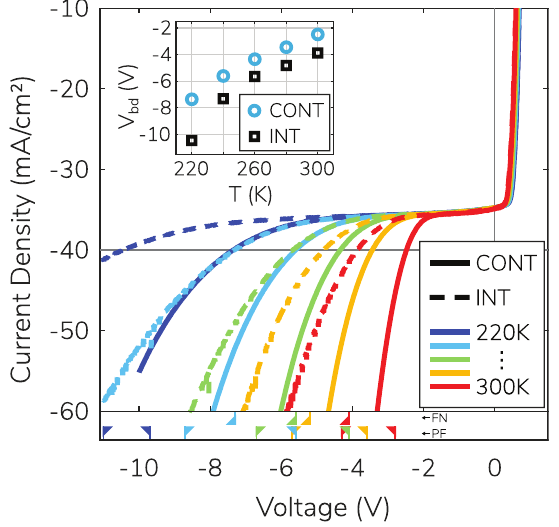
Fig. 3. Temperature-dependent breakdown behaviour for con- tinuous (solid lines) and intermittent (dashed lines) voltage sweeps. The coloured arrows at the bottom indicate the limits of the linear regions of the INT data in the Fowler-Nordheim (FN) and Poole-Frenkel (PF) plots (only lower limit for FN). Inset: Breakdown voltage as V ( (cid:3) 40mA/cm 2 ) as a function of